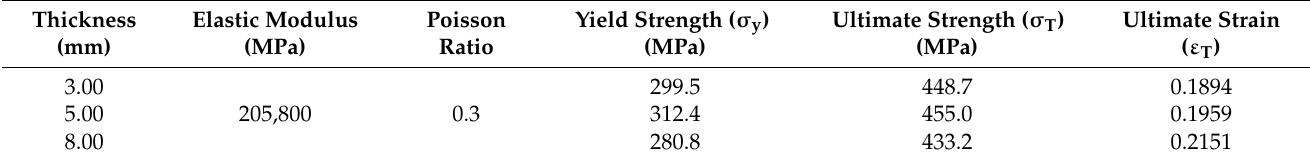
Figure 4. Multilinear plasticity model for steel box. Table 2. Material properties for steel box [4].